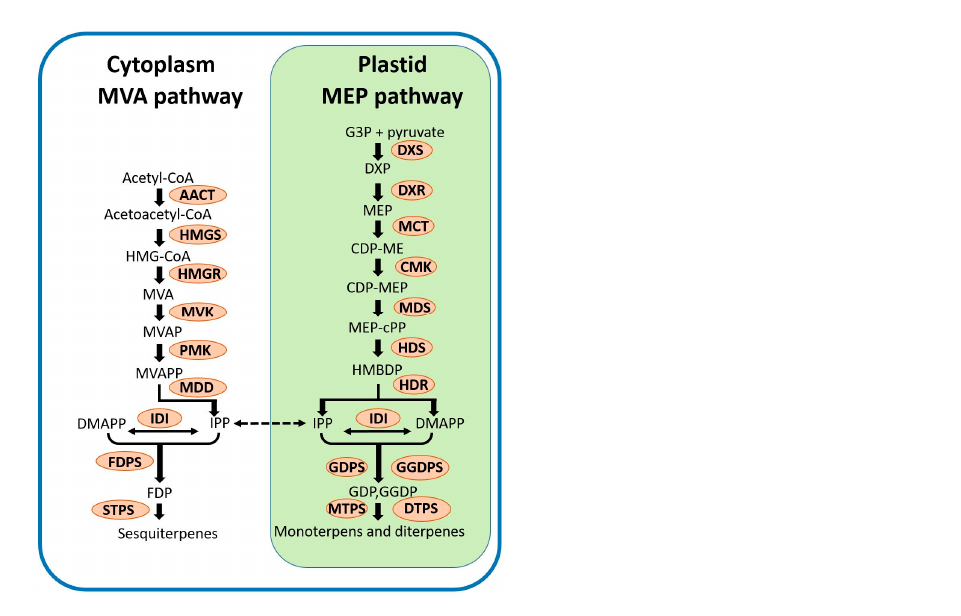
Figure 1. The MVA (left) and MEP (right) pathways responsible for IPP and DMAPP biosynthesis and monoterpene biosynthesis in plants. AACT, acetoacetyl-CoA thiolase; CMK, 4-(cytidine 5 ′ -diphospho)-2- C -methyl-d-erythritol kinase; DMAPP, dimethylallyl diphosphate; DXR, 1-deoxy-d-xylulose 5-phosphate reductoisomerase; DXS, 1-deoxyd- xylulose 5-phosphate synthase; FDP, farnesyl diphosphate; FPPS, farnesyl diphosphate synthase; G3P, d-glyceraldehyde 3-phosphate; GDPS, geranyl diphosphate synthase; GDP, geranyl diphosphate; HDR, ( E )-4-hydroxy-3-methylbut-2-enyl diphosphate reductase; HDS, ( E )-4-hydroxy-3-methylbut-2-enyl diphosphate synthase; HMGR, 3-hydroxy-3-methylglutaryl-CoA reductase; HMGS, 3-hydroxy-3-methylglutaryl- CoA synthase; IDI, isopentenyl diphosphate isomerase; IPP, isopentenyl diphosphate; MCT, 2- C -methyl-d-erythritol 4-phosphate cytidylyltransferase; MDD, mevalonate diphosphate decarboxylase; MDS, 2- C -methyld-erythritol 2,4-cyclodiphosphate synthase; MVK, mevalonate kinase; MVAP, mevalonate 5-phosphate; MVAPP, mevalonate diphosphate; PMK, phosphomevalonate kinase; TPS, terpene synthase.